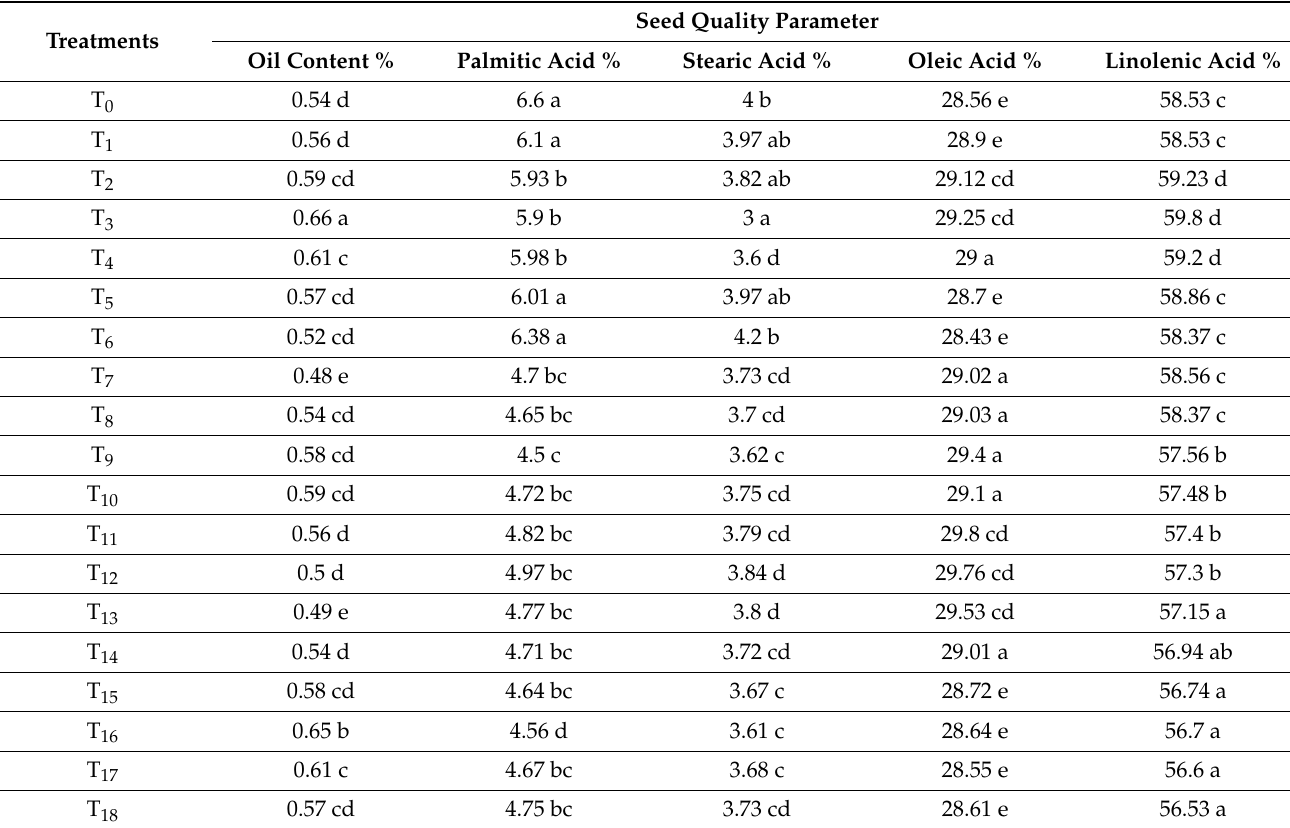
Table 2. Seed-quality parameters in terms of oilseed and fatty acid contents of sunflower.